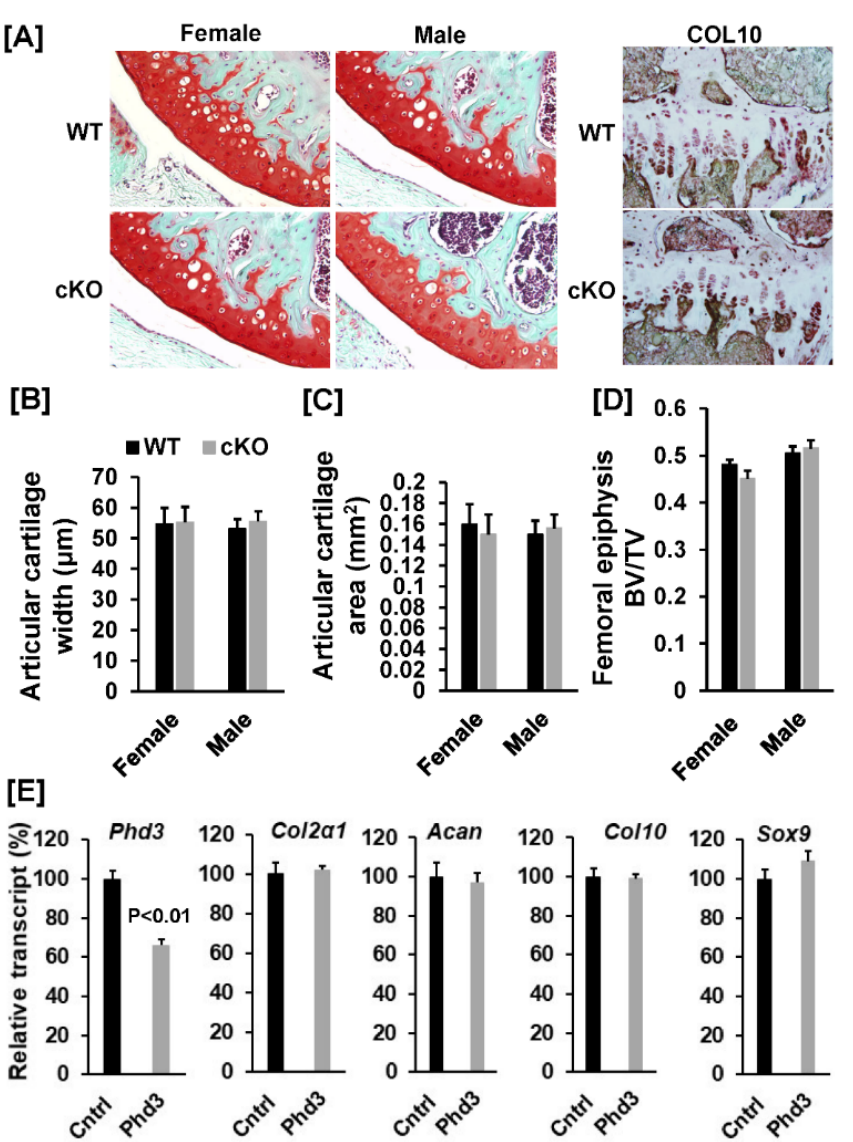
Figure 6. Knockdown of Phd3 expression did not influence chondrocyte differentiation. ( A ): Bone sections from the distal femurs of the WT and cKO female mice were stained with safranin red and methyl green. Articular cartilage was stained as red. Bone sections from the distal femurs of the WT and cKO female mice were also immuno-stained with Collagen 10 (Col10)